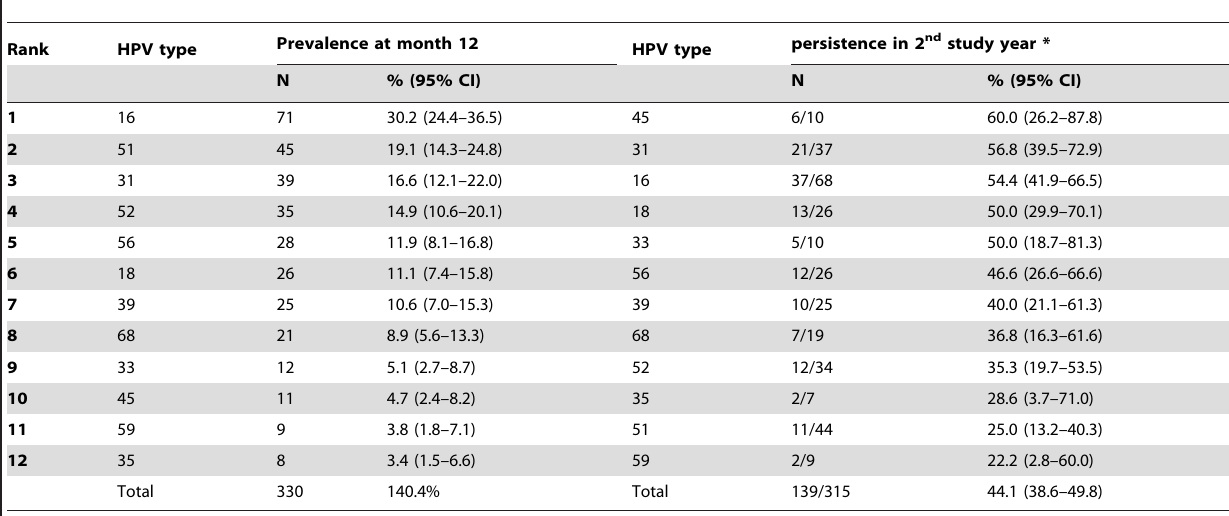
Table 3. Ranking of type-specific hr-HPV prevalence at month 12 and type-specific hr-HPV persistence in 2 nd study year.